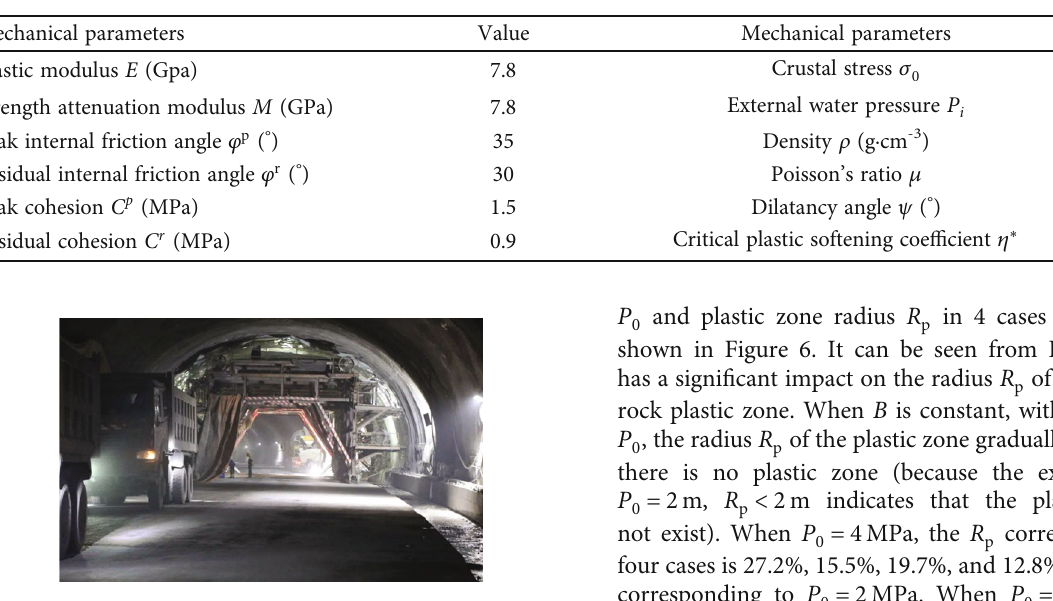
Table 1: Mechanical parameters of surrounding rock of the example project.